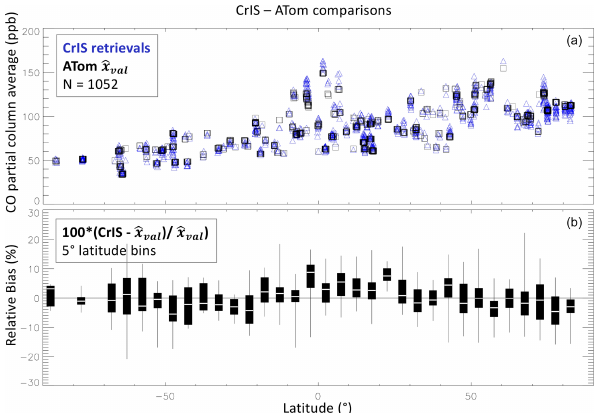
Figure 9. Latitude dependence of partial column average CO for each ATom campaign. Black squares show ATom ˆ x val partial col- umn average values over Atlantic Ocean scenes; black circles in- dicate ATom values over Pacific Ocean scenes. Blue triangles in- dicate CrIS CO partial column average values over land and At- lantic Ocean scenes; red diamonds indicate CrIS values over Pacific Ocean scenes.